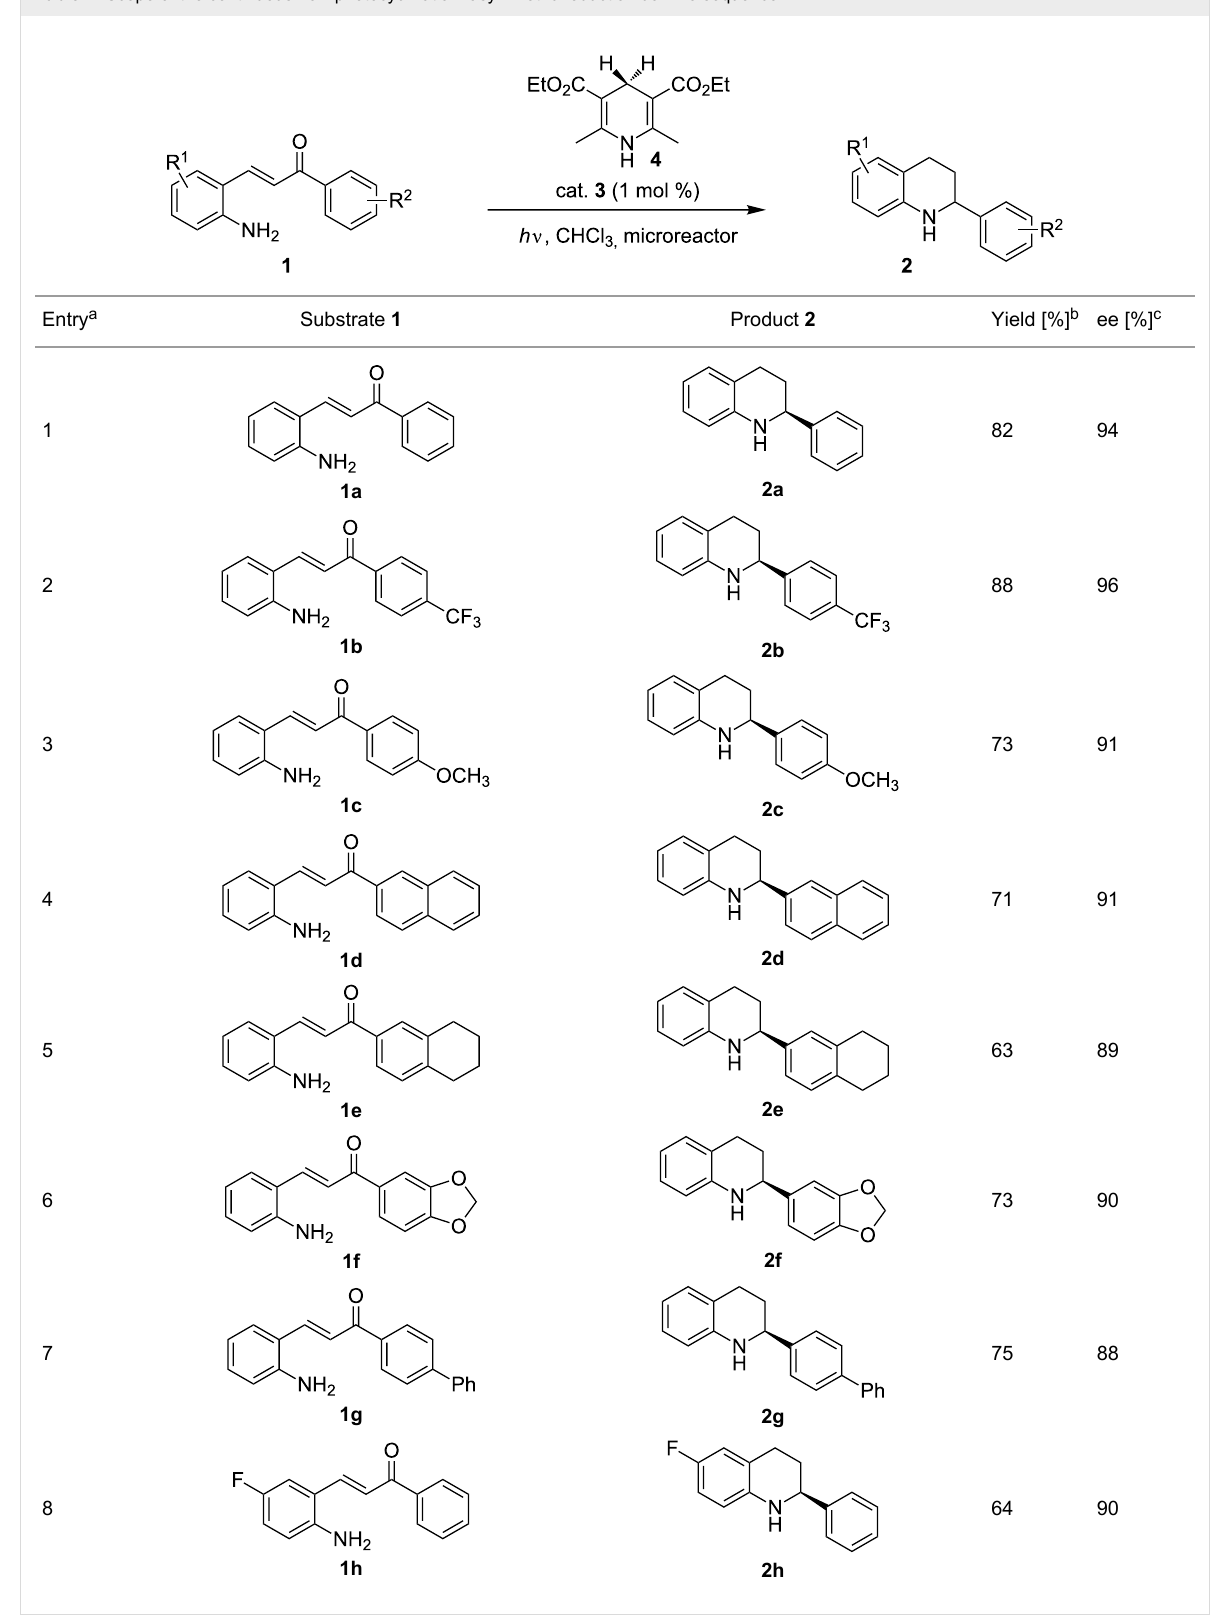
Table 2: Scope of the continuous-flow photocyclization–asymmetric reduction domino sequence.